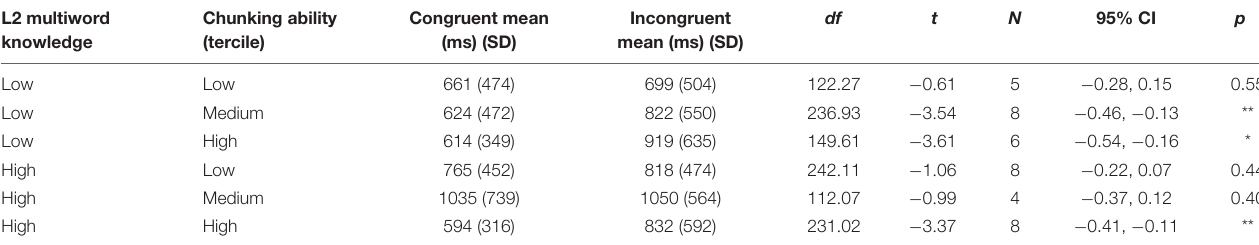
TABLE 5 | Results of the dedicated congruency-based pairwise comparisons.